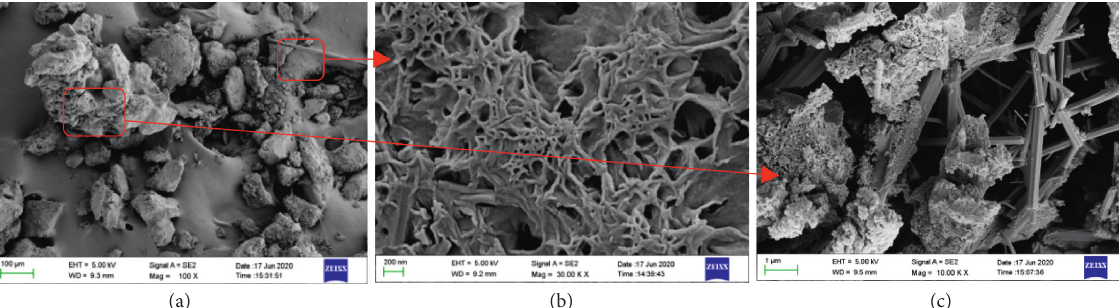
Figure 7: Microstructure of saline soils stabilised with Portland cement. (a) Close-up of specimen; (b, c) hydration products.